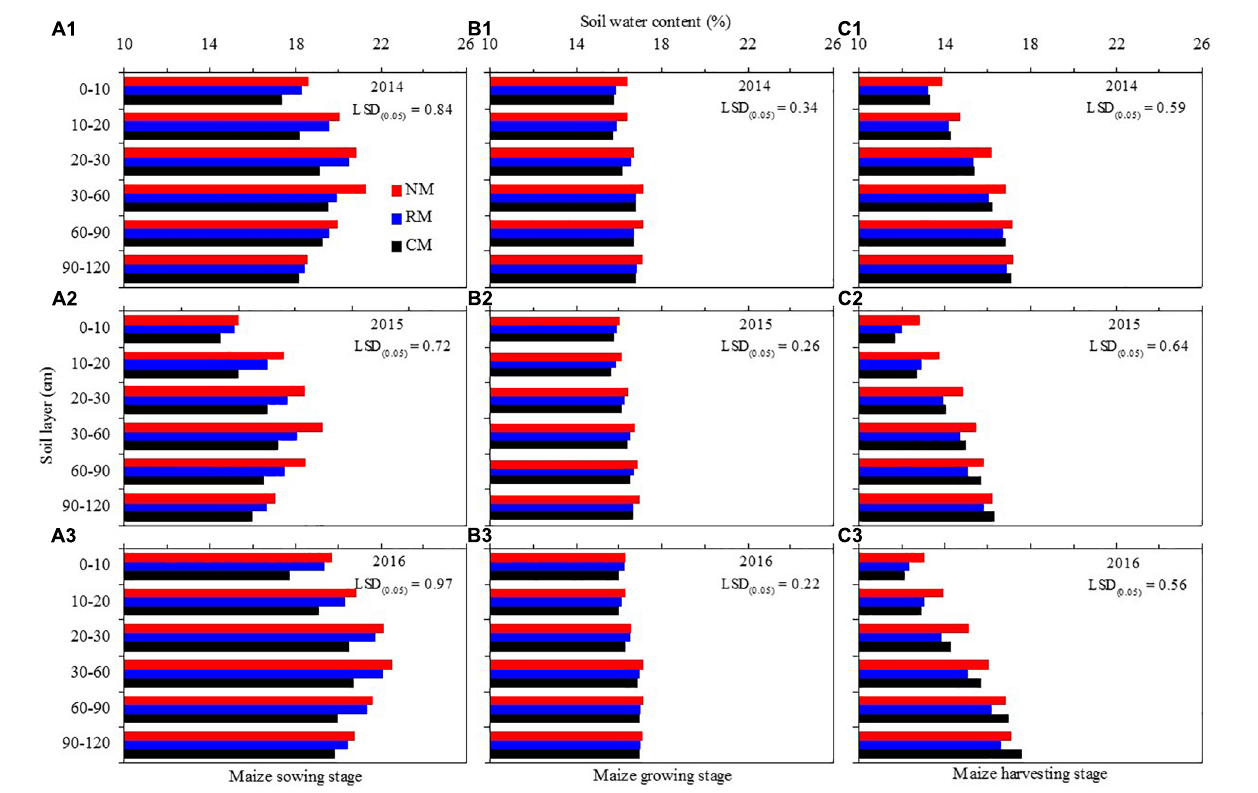
FIGURE 6 | Soil water content by soil layer in maize field as affected by plastic mulching practices during different growth periods in 2014–2016. Soil water content before maize sowing (A1–A3) , maize growth period (B1–B3) , and after maize harvesting (C1–C3) . NM, no tillage with plastic re-mulching; RM, no tillage with plastic mulching after maize was harvested in autumn and new plastic was mulched in next spring after the old plastic was removed off the field and rotary ploughed; CM, conventional deep tillage (the depth is 30 cm) after maize was harvested and the old plastic was removed off the field in autumn, and new plastic was mulched in next spring before maize sowing. The value in each figure is the least significant difference (LSD) of all treatments among soil depths at P <